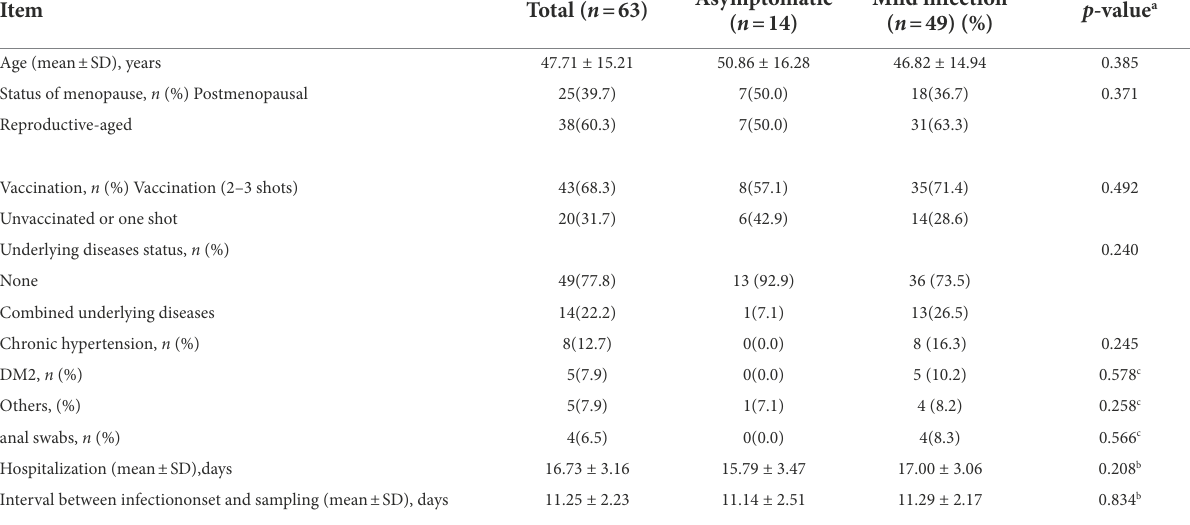
TABLE 1 Demographic and clinical characteristics of the